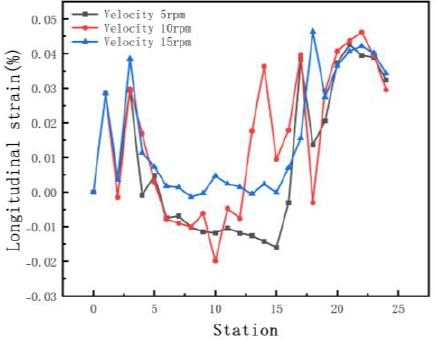
Figure 19. The variation in the equivalent von Mises stress distribution of strip under different velocities.